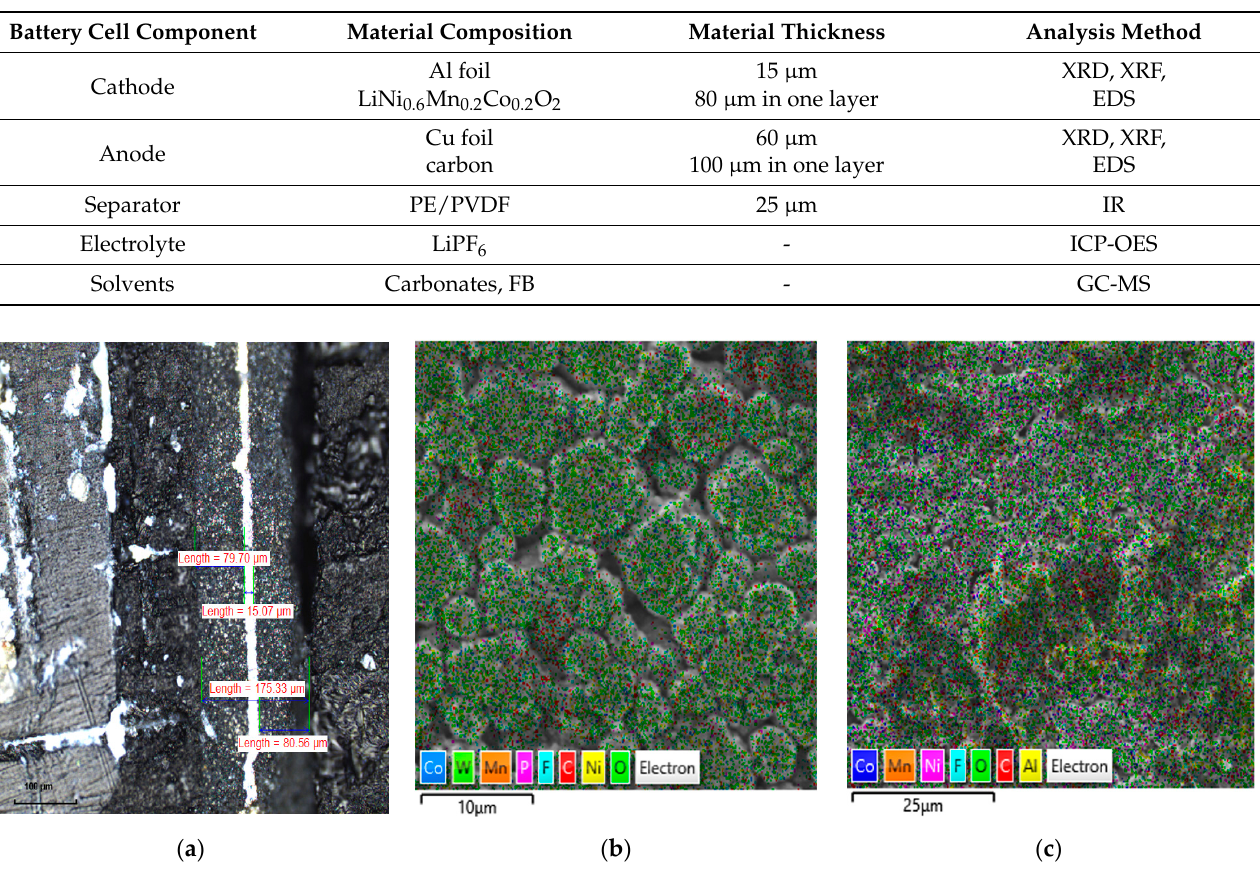
Table 1. The material composition of the individual components of the battery cell; average thick- nesses of individual material layers; methods used to characterize the material composition.